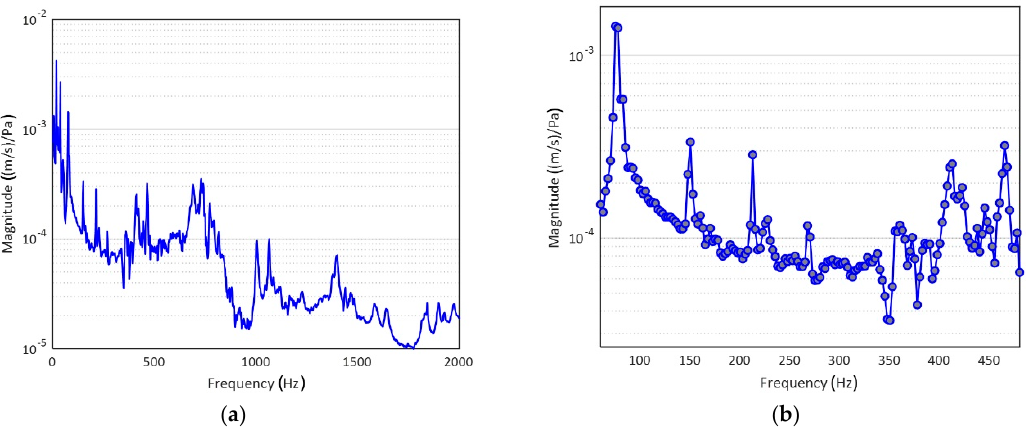
Figure 15. Laser vibrometry results, Frequency Response Functions (FRF) between surface vibration and acoustic pressure: ( a ) broad-spectrum analysis ; ( b ) spectral windowing of modal region.